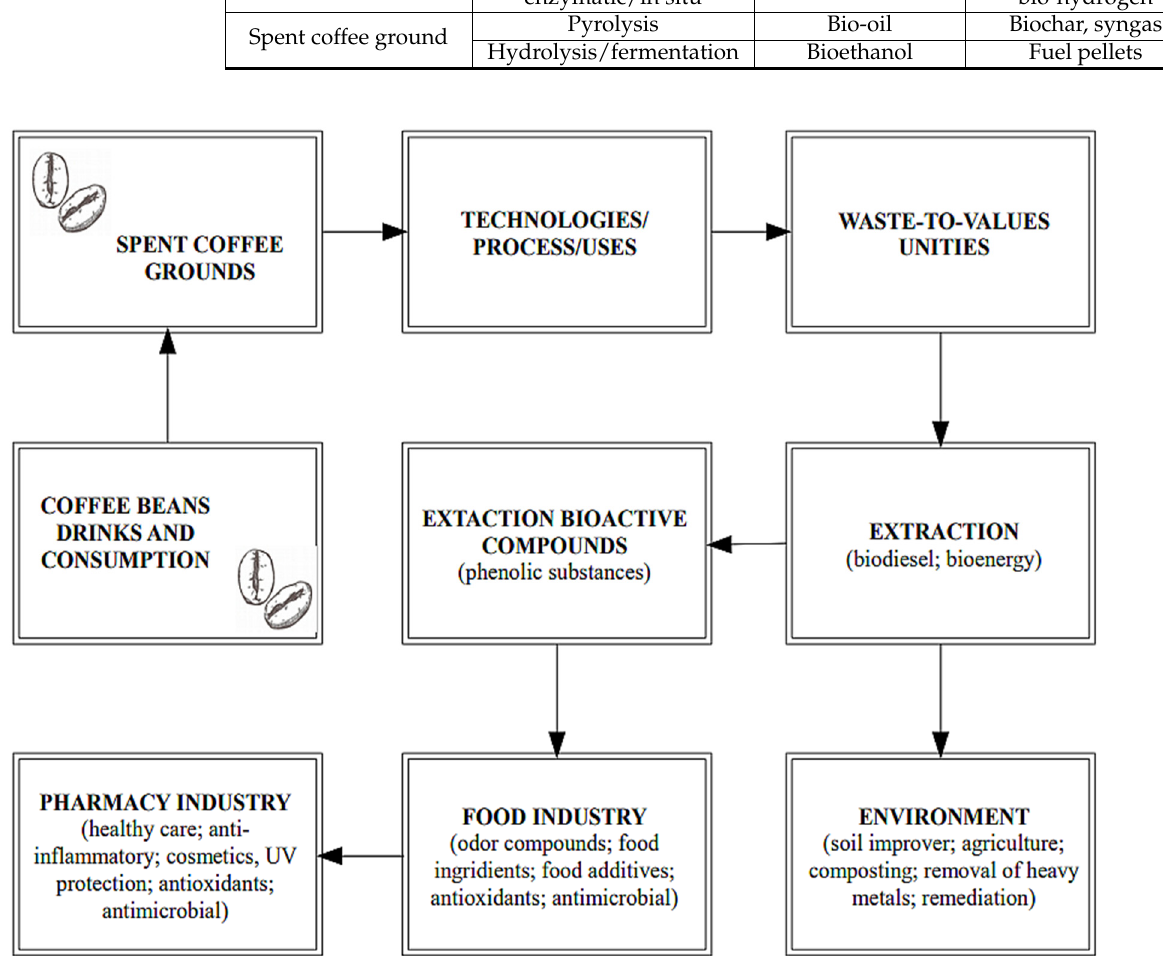
Figure 6. Overview of potential usages of spent coffee grounds. Own compilation based on literature data [95].